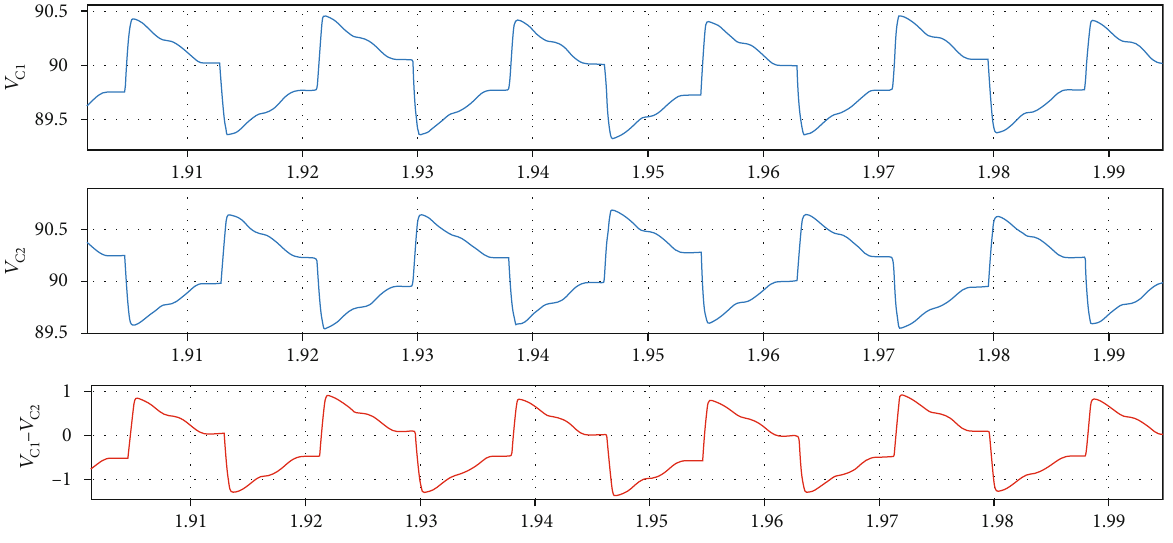
Figure 18: DC link capacitor voltage in nonlinear